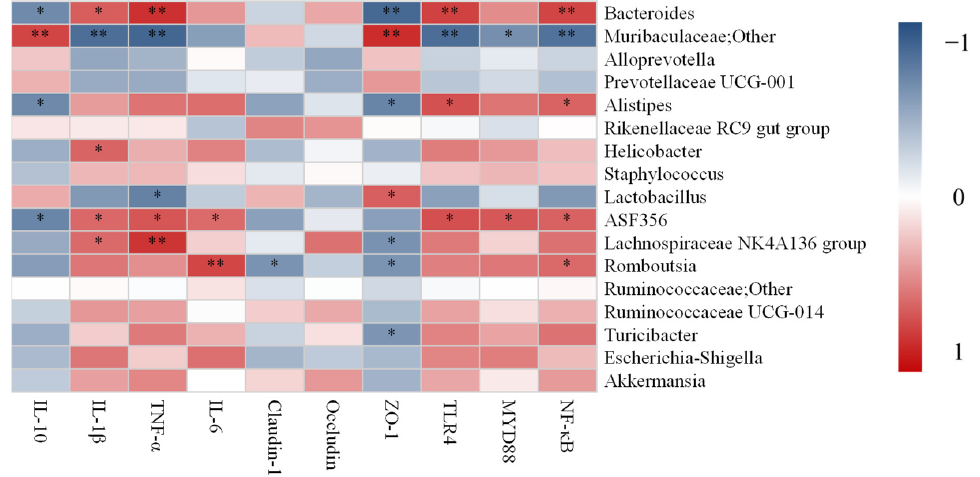
Figure 7. Correlation analysis between UC-related symptoms, related gene expression, and dominant gut microbiota by Spearman. * and ** indicate the associations significant ( p < 0.05 and p < 0.01, respectively).